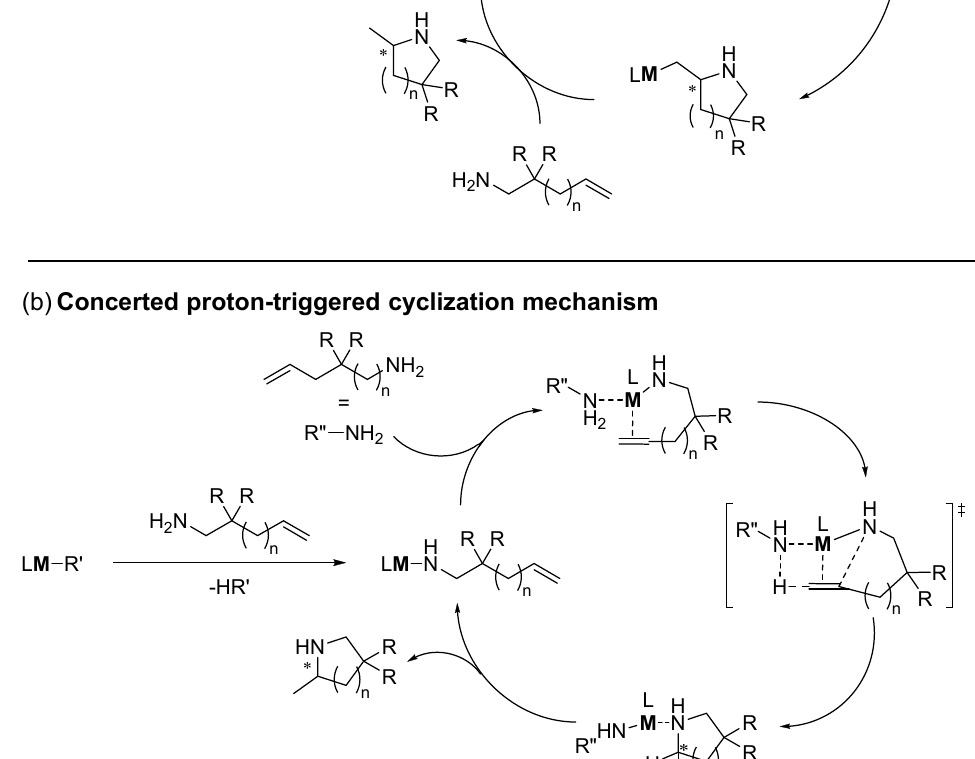
Figure 2. The σ‐ insertive ( a ) and concerted proton ‐ triggered cyclization mechanism ( b ) for intra ‐ Figure 2. The σ -insertive ( a ) and concerted proton-triggered cyclization mechanism ( b ) for intramolec- ular hydroaminations [29,33,54,59,61,64,65,68,71,72]. molecular hydroaminations [29,33,54,59,61,64,65,68,71,72]. One example is the enantioselective and regioselective hydroamination of aminoalkenes 1a , b and 2a , b to give chiral pyrrolidines 3a , b or piperidines 4a , b with C 1 -symmetric lanthanide ansa complexes: ( S )-[Me 2 Si( η 5 -C 5 Me 4 )( η 5 -C 5 H 3 R*)]Ln-E(TMS) 2 ( 5a – n , Ln = Y, La, Sm, Nd, Lu; E = N, CH; R* = ( − )-menthyl, (+)-neomenthyl; TMS = SiMe 3 ) [54,73] and ( S )-[Me 2 Si(OHF) ( η 5 -C 5 H 3 R*)]LnN(TMS) 2 ( 6a – c , Ln = Y, Sm, Lu; OHF = η 5 -octahydrofluorenyl) [60] serving as catalysts (Scheme 1, Table 1)